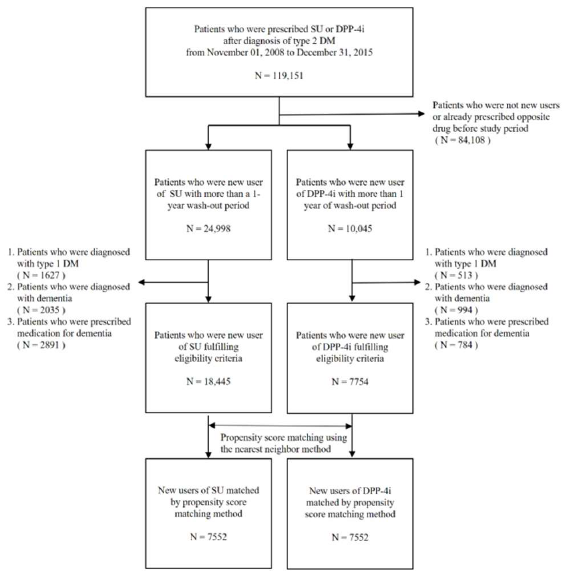
Figure 1. Flow chart of the sample selection process. DM, diabetes mellitus; DPP-4i, dipeptidyl-peptidase IV inhibitor; N, number; SU, sulfonylurea.